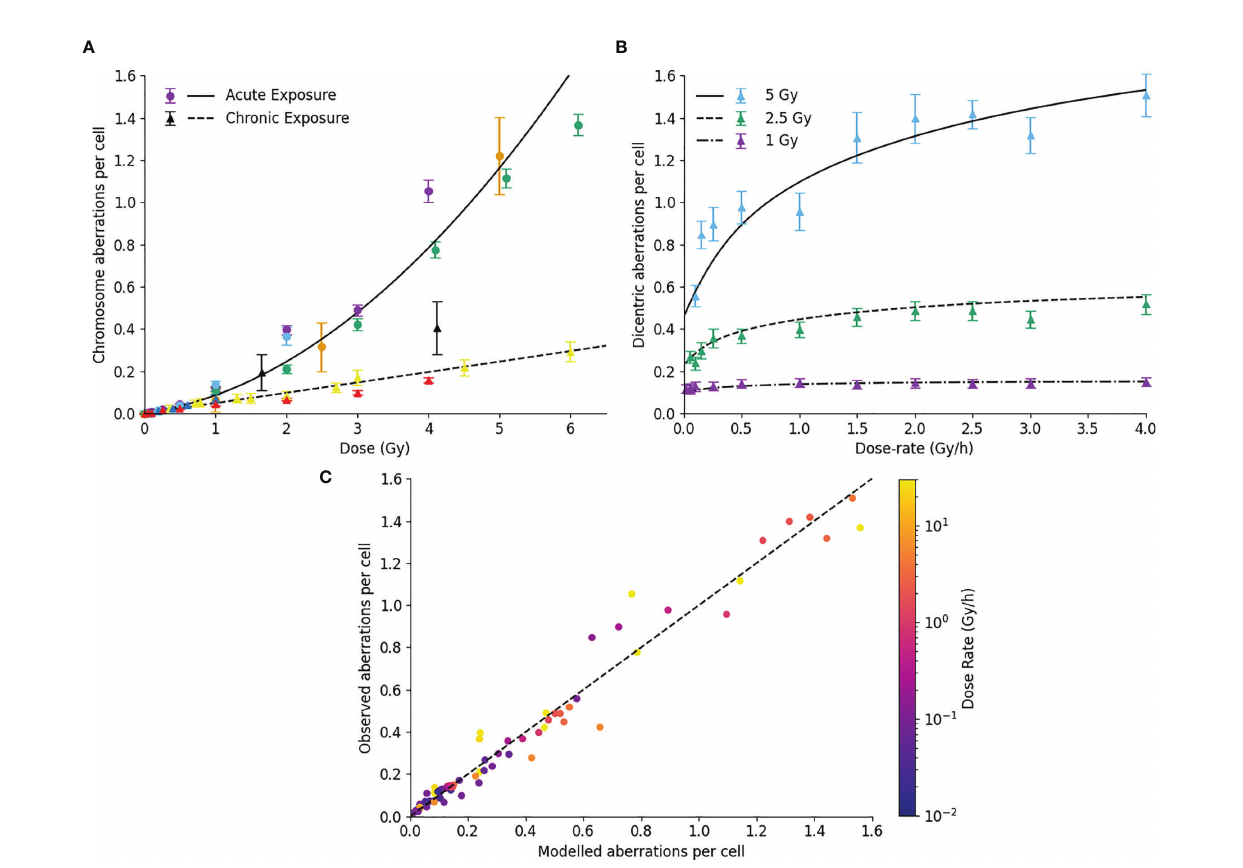
FIGURE 6 | Impact of dose rate on misrepair. (A) Comparison of modelled and observed chromosome aberration yields for acute X-ray exposures (circles, solid line) and chronic low dose-rate exposures (triangles, dashed line). Different colours are used to represent different data sources. (B) Impact of dose-rate on dicentric aberration yield at a series of different dose levels in human lymphocytes. (C) Correlation of modelled and observed chromosome aberration yields, across a range of doses, dose-rates, and underlying biologies, with points coloured according to the delivered dose rate. Best fi tting line has a slope of 0.99, with an R 2 of